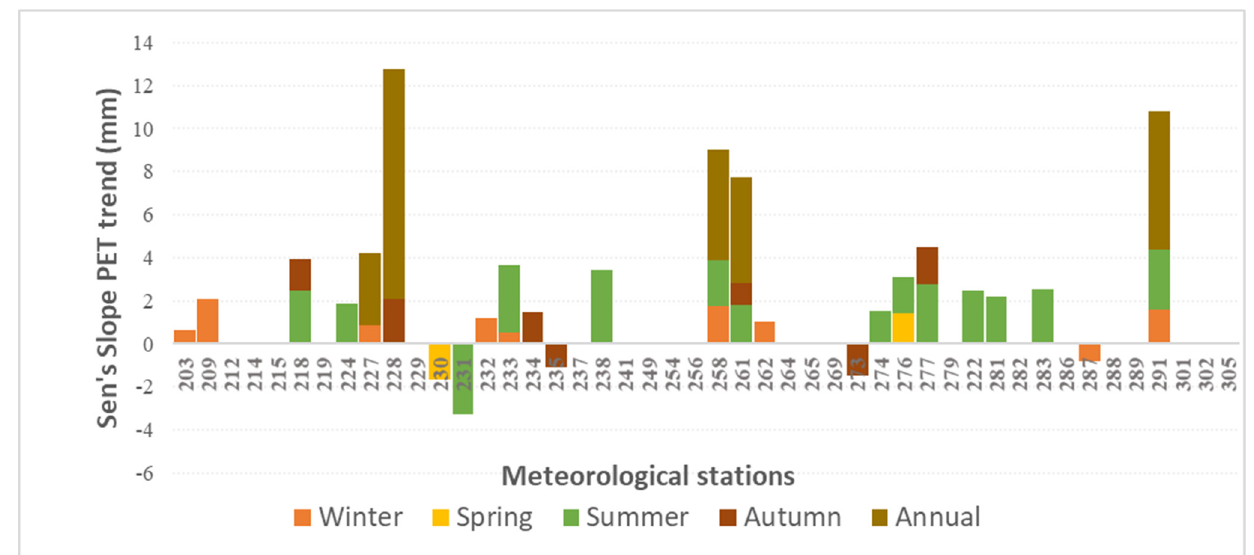
Figure 5. The monthly trend Sen’s slope magnitude of PET in mm in all analysed meteorological stations.